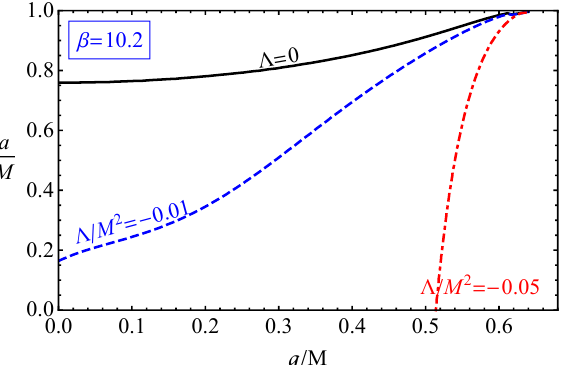
Figure 17. The degeneracy between the spin parameter of the Kerr BH and the magnetic charge parameter of the Bardeen BH in AdS spacetime for the matching radiative